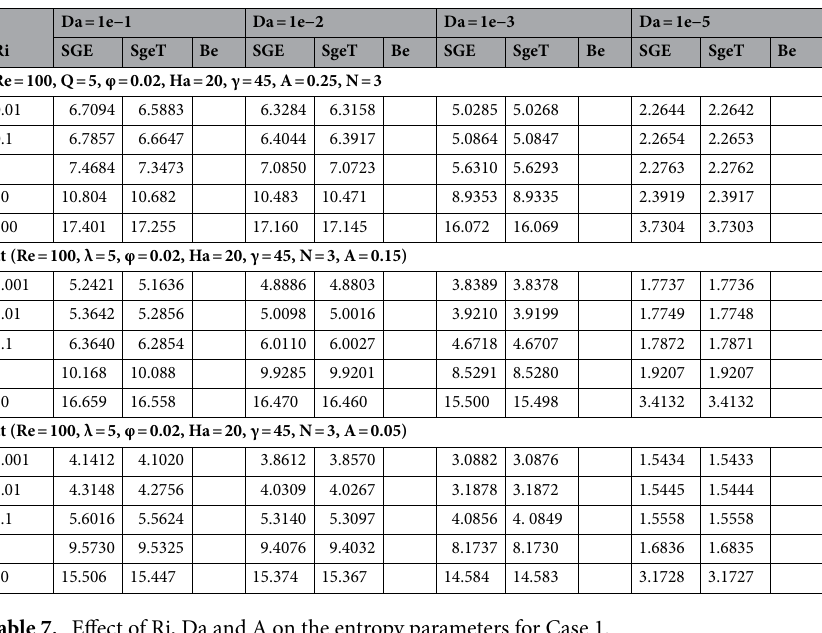
Table 7. Effect of Ri, Da and A on the entropy parameters for Case 1.